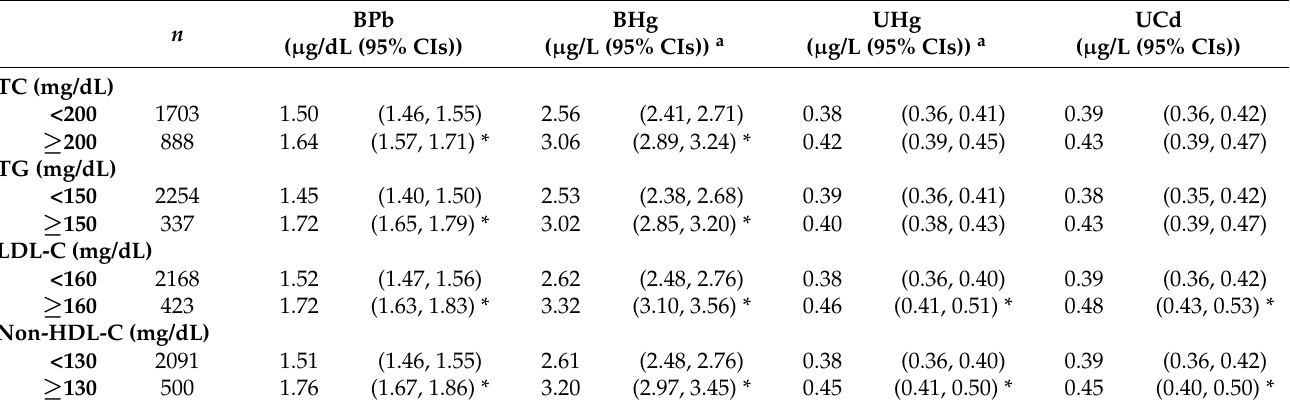
Table 2. Geometric means of heavy metal concentrations, according to the dyslipidemia or non- dyslipidemia group ( n =